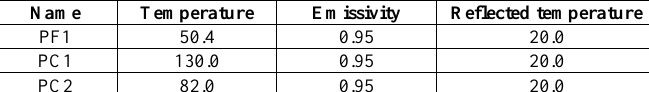
Figure 4: Cells with critical damage. Table 3: Markers referring to the analysis of Figure 4.